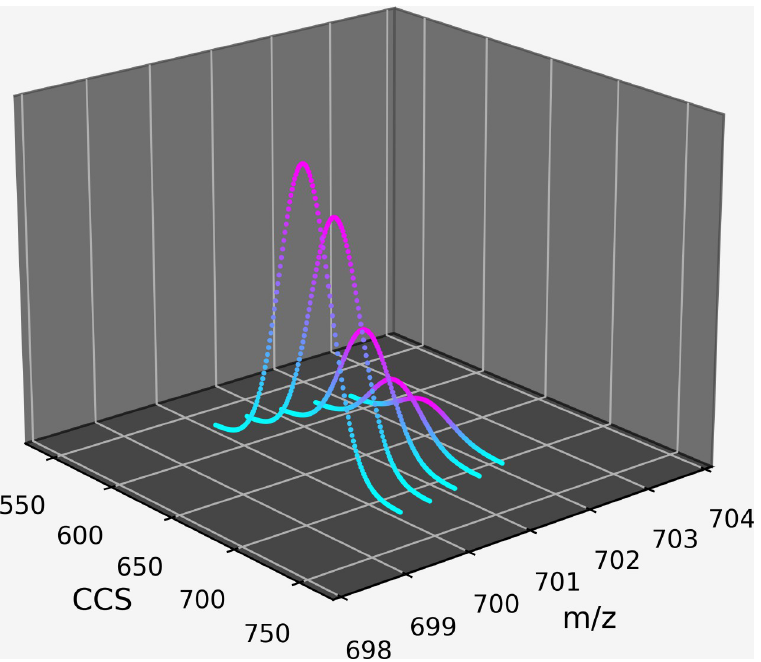
Fig 3. An artificial representation of a peptide’s isotopic peak series in the m/z, CCS, and intensity dimensions at an instant of retention time. m/z dimension [12], the distance between them being determined by their integer charge state. Isotopic peaks in a series are aligned in the mobility and retention time dimensions. The raw MS1 data space is divided into voxels (volumetric pixels), a small region of 3D m/ z, mobility, and retention time space, ranked in descending order by the mean intensity of their constituent raw points. Voxels with fixed dimensions of 0.1 in m/z, 10 scans in mobility, and 5 seconds in retention time are used, where the rationale is to capture a single isotopic peak in the m/z dimension, and to sample the peak in the mobility and retention time dimen- sions broadly enough to find its apex. A peak encompassed by such a voxel is likely to be a good candidate for a precursor feature’s monoisotopic peak or its base peak. As there are many thousands of voxels to process, processing parallelism is achieved by dividing the m/z dimension into bands of 10 Th through retention time and mobility; a worker is assigned a band in which to process its voxels. To group the raw points of the candidate peak, the voxel’s intensity-weighted m/z centroid is determined. The peak delta either side of the centroid is determined by calculating three standard deviations based on the instrument’s resolution of 40,000. The raw points within 3 σ either side of the m/z centroid are grouped as the peak’s m/z dimension. An example voxel, its candidate peak constrained in the m/z dimension, and the raw data in its vicinity are shown in Fig 4. To find the peak’s apex in mobility, we begin by taking points ± 40 scans (a number selected because it is twice the mean peak width in the mobility dimension) from the voxel’s mobility midpoint and flattening the points to the mobility dimension by grouping the points that lie on the same scan and summing their intensity. A smoothing Savgol-Golay filter [13] is applied to facilitate the determination of the peak’s apex and valleys with the peakutils [14] Python package. In instances where we find multiple apexes, we take the apex closest to the voxel’s